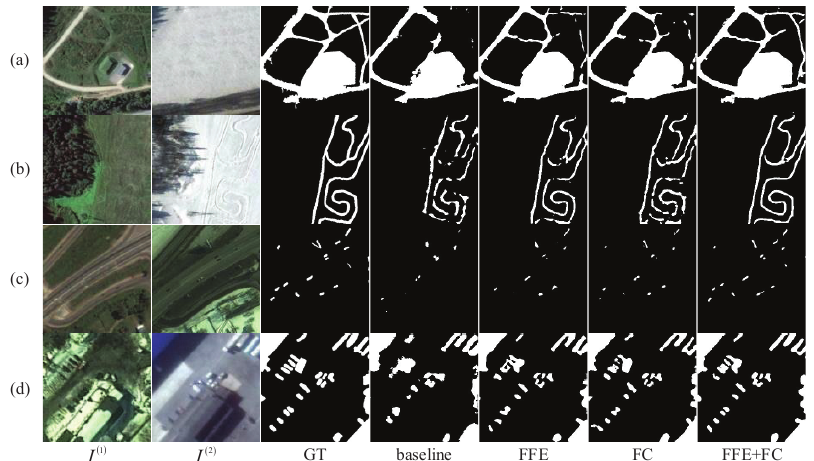
Figure 9. Comparison of visualization results of full-scale feature extractor (FFE) and full-scale classi- fier (FC) on CDD test set. I ( 1 ) and I ( 2 ) represent bi-temporal images, GT indicates the ground